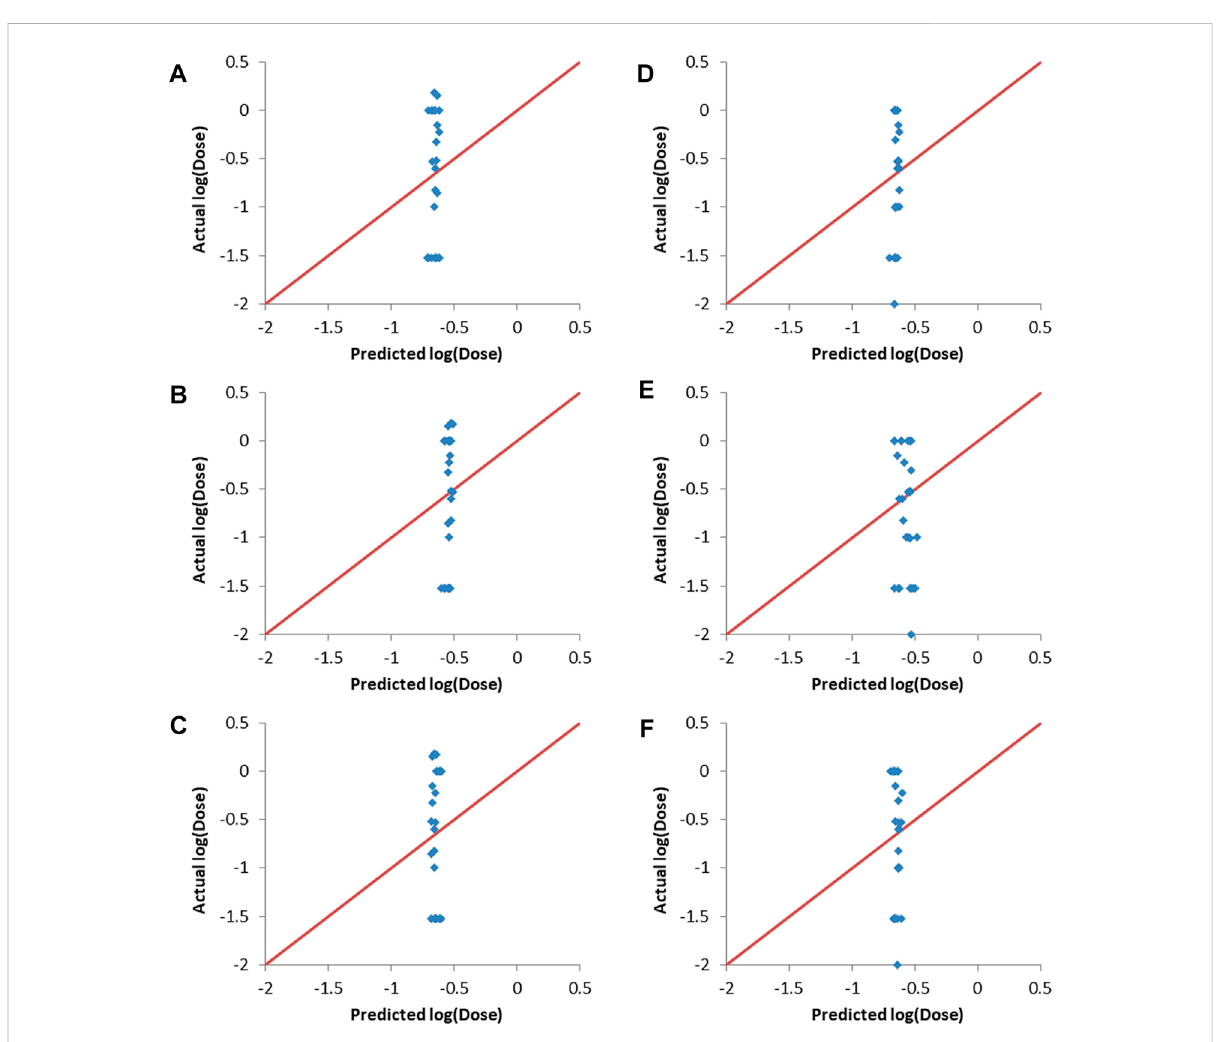
FIGURE 5 Actualvspredictedresponsesofvalidationsets afterY-randomization oftraining setsresponses. (A – C) validation setone. (A) ANN, (B)